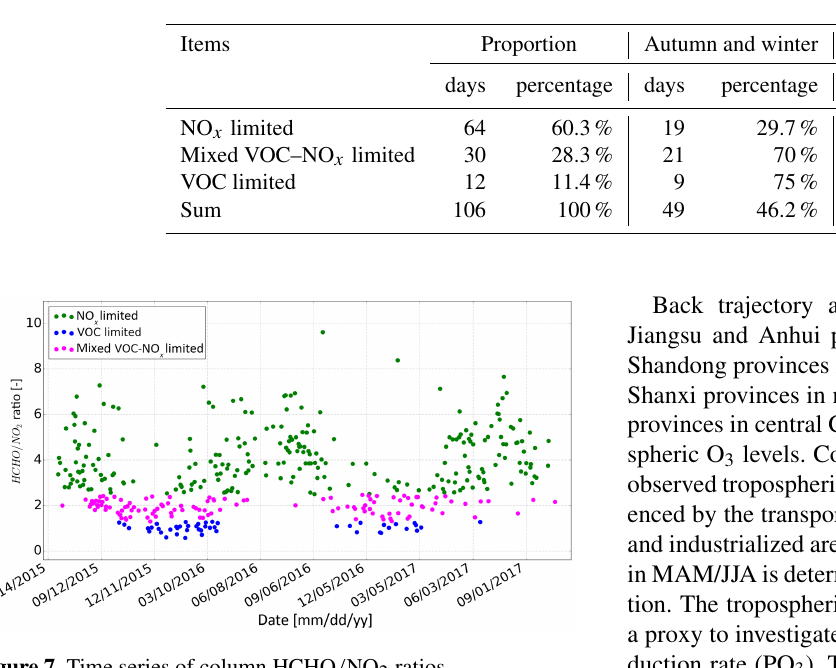
Table 4. Chemical sensitivities of PO 3 for the selected 106 days of observations that have coincident O 3 , HCHO, and NO 2 counterparts.